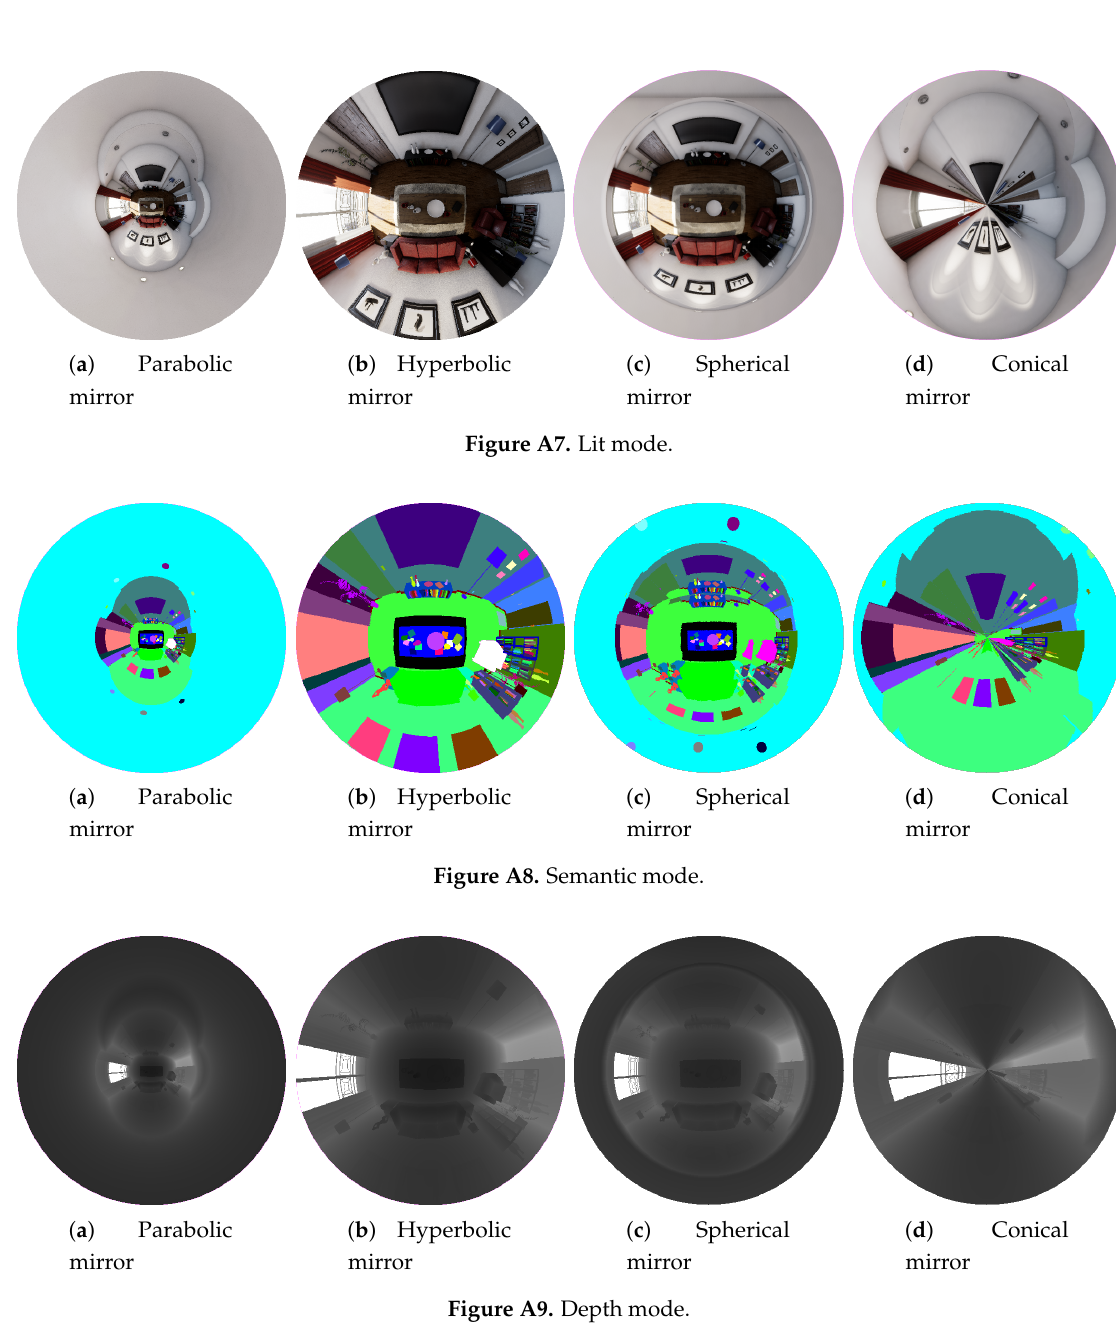
Figure A9. Depth